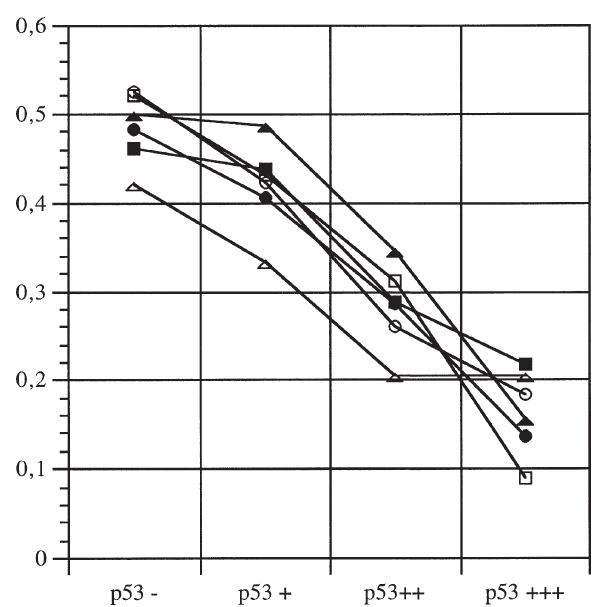
Fig. 3. Skewness of the optical density histogram of the nucleus in nuclear subpopulations with different p53 expression in correlation to DNA ploidy, S-phase and G2M-fraction. p53 − . . . p53 negative nuclei; p53 + . . . weakly p53 positive nuclei; p53 + + . . . moderatly p53 positive nuclei; p53 + + + . . . strongly positive nuclei. 1 peri-, di- and tetraploid; 2 aneuploid; ! S-phase < 5%; " S-phase > 5%; P G2M-fraction < 5%; Q G2M-fraction > 5%.